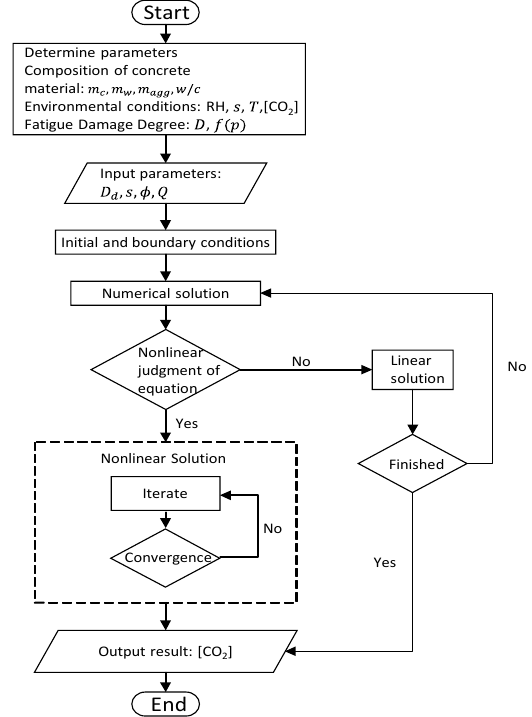
Figure 15. The numerical simulation flowchart on carbonation process of fatigue-damaged RC beams.